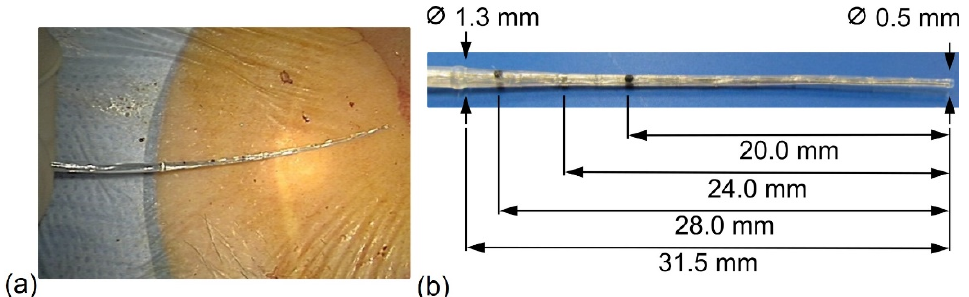
Figure 1. Dimensions of the IE stiff CMD. ( a ) Intraoperative; ( b ) markings on the IES CMD array. The IES CMD has a maximal insertion length of 31.5 mm.